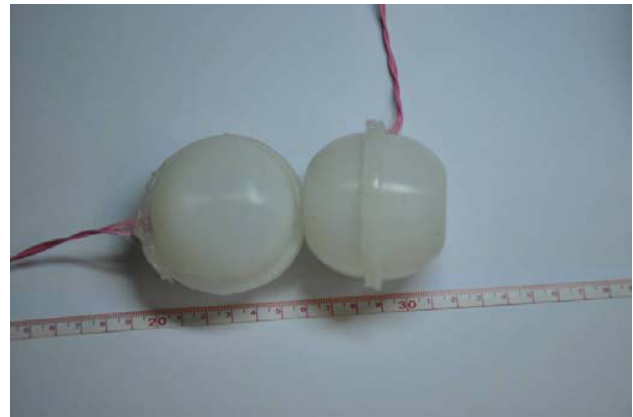
Figure 9. Photograph of plantar force sensing unit.